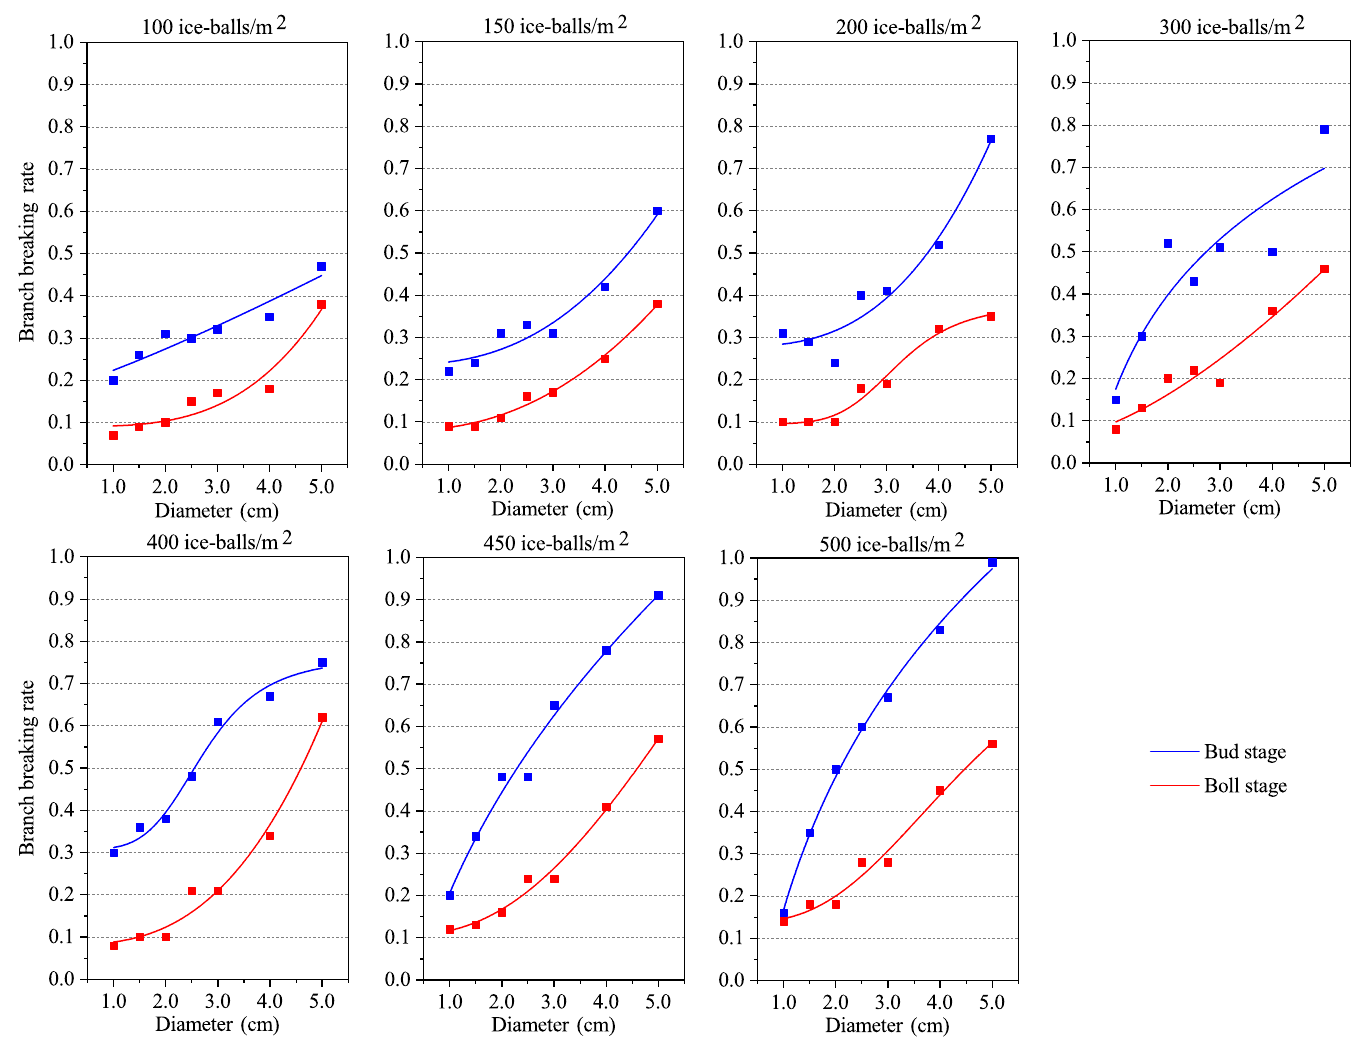
Fig 2. Logistic relation between the branch breaking rate and hail